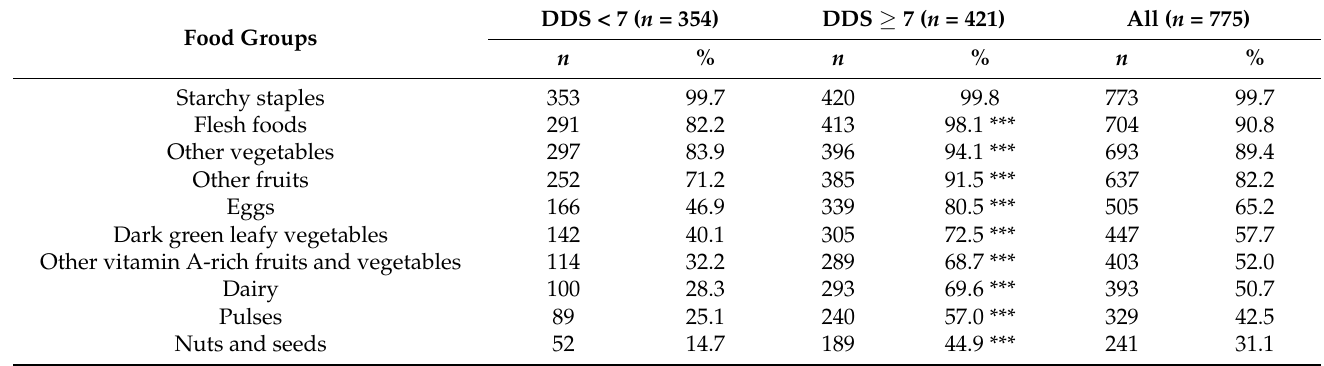
Table 2. Proportions of food group consumption according to the dietary diversity score (DDS).